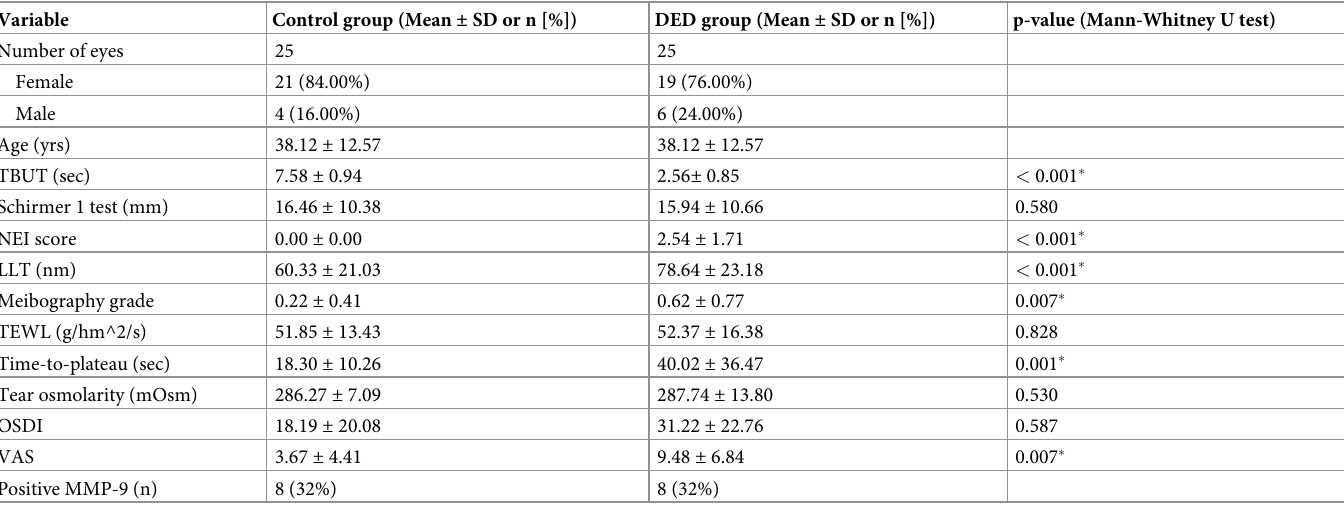
Table 1. Clinical characteristics of the study participants.